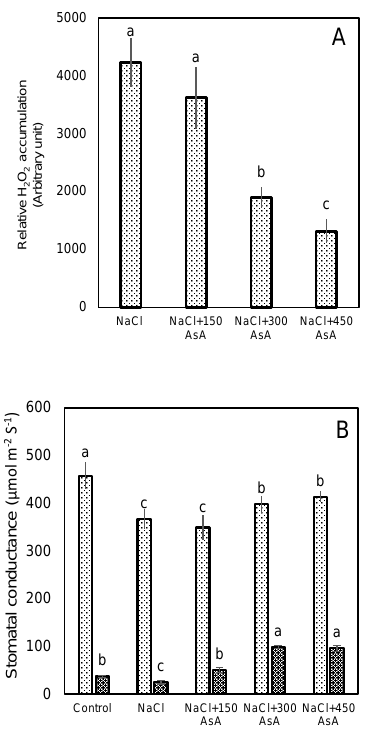
Figure 12. ( A ) E ff ect of di ff erent concentrations of ascorbic acid on H 2 O 2 of levels in the GCs of sugar beet plants grown under saline conditions, relative to non-stressed controls. Relative signal intensities of DAB staining were quantified using ImageJ software. ( B ) Stomata conductance in non- stressed sugar beet leaves and salt- stressed leaves with or without ascorbic acid treatment. The light bar and dark bar are stomata conductance measurements under natural light conditions and under 30 min-dark conditions, respectively. Values are means of 5 replicates ± SE. Data labeled with di ff erent lower-case letters are significantly di ff erent at p <